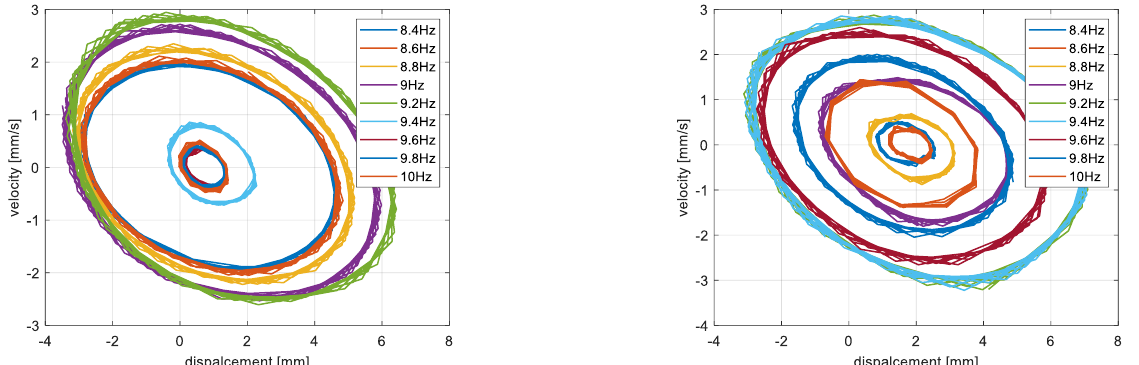
Figure 14. Comparison of portrait phases of the upper and lower beams of the structure in three different beam spaces.